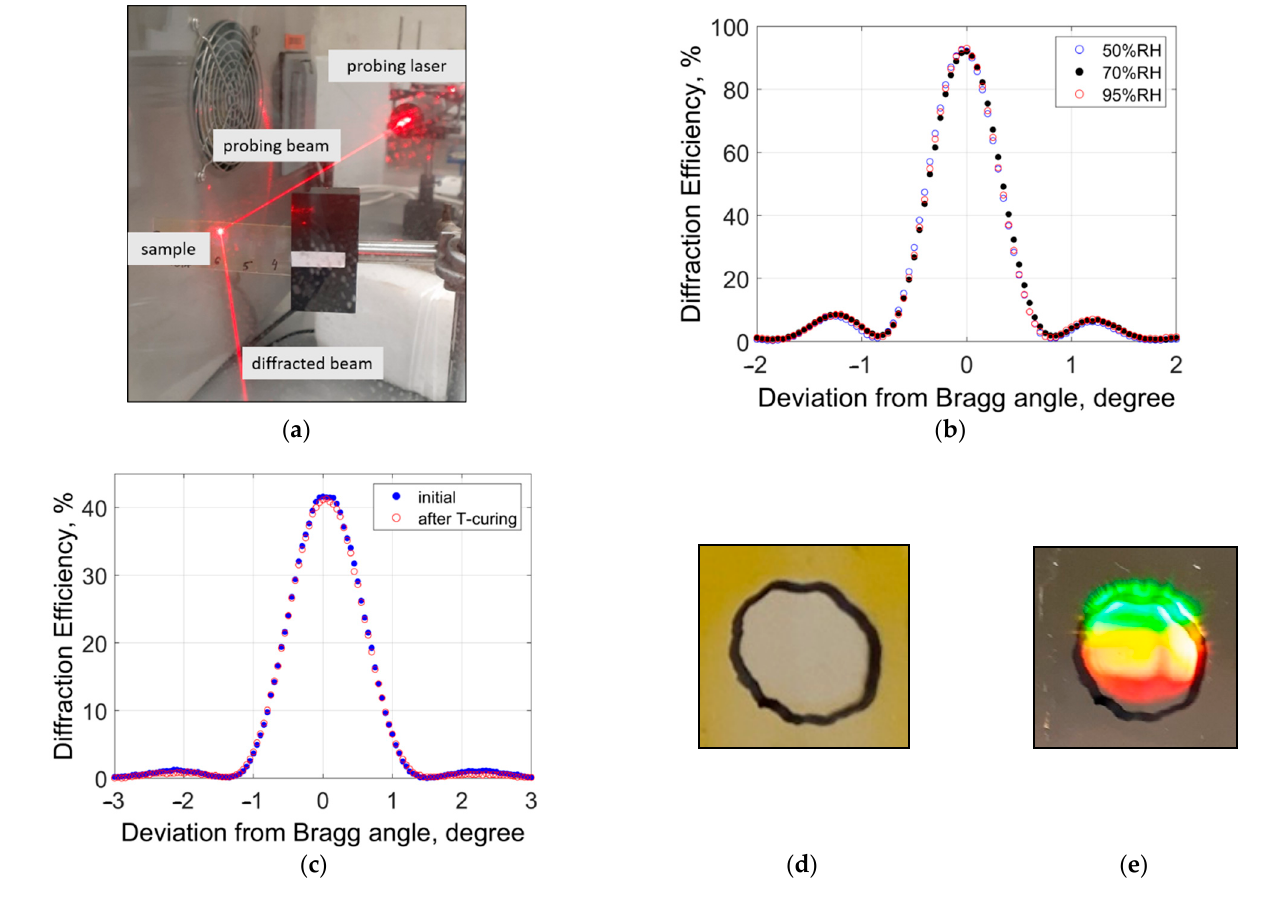
Figure 6. ( a ) Photograph of the experimental set-up for monitoring the impact of humidity on the diffraction efficiency of transmission gratings recorded on PHSG layers; ( b ) Bragg selectivity curves of the transmission grating at different levels of relative humidity; ( c ) Bragg selectivity curves of the transmission grating measured before and after curing at 130 °C for 60 min; ( d ) Photograph of the PHSG layer after curing at 130 °C for 60 min where the clear part corresponds to the area of the grating; ( e ) image of the grating (same sample as shown in Figure 3d) under ambient light illumination after curing at 130 °C for 60 min.